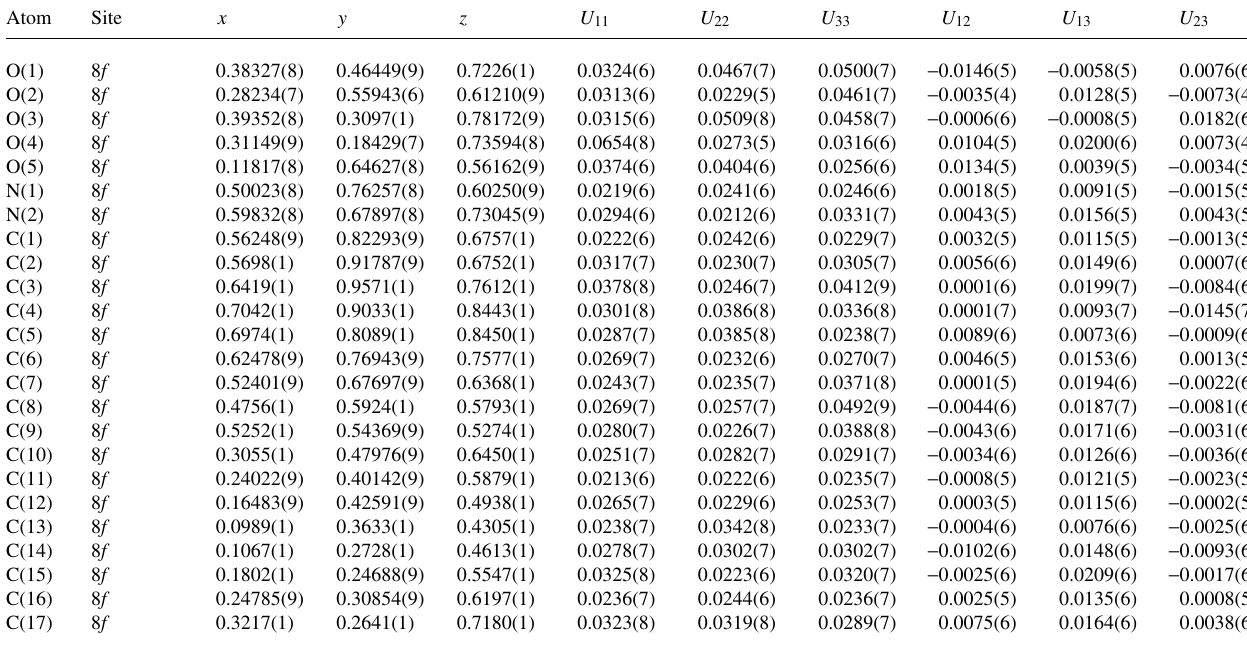
Table 3. Atomic coordinates and displacement parameters (in Å 2 )